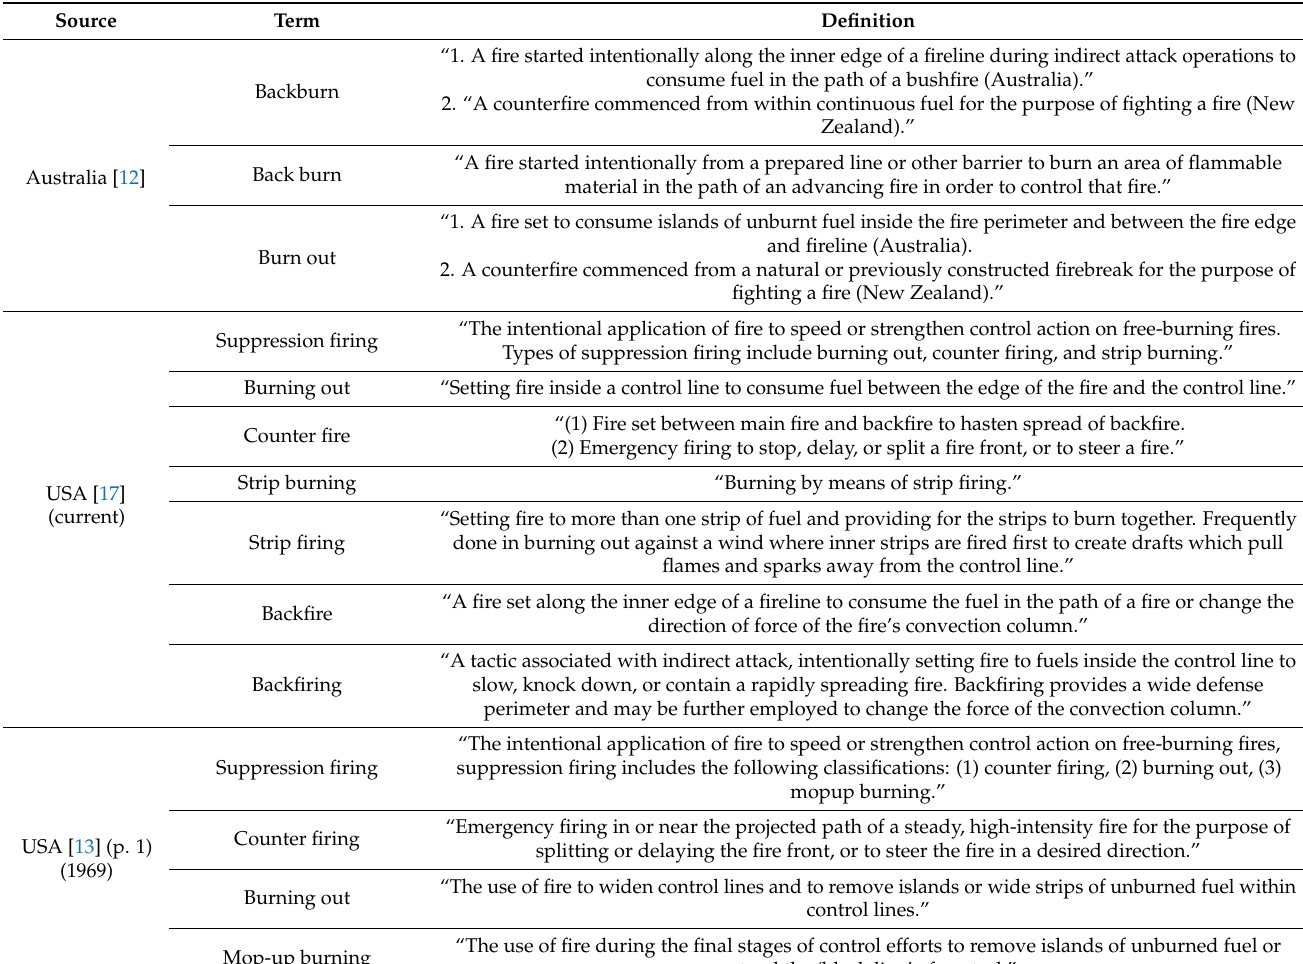
Table 2. Examples of the variation in suppression firing definitions: Australia and the USA.